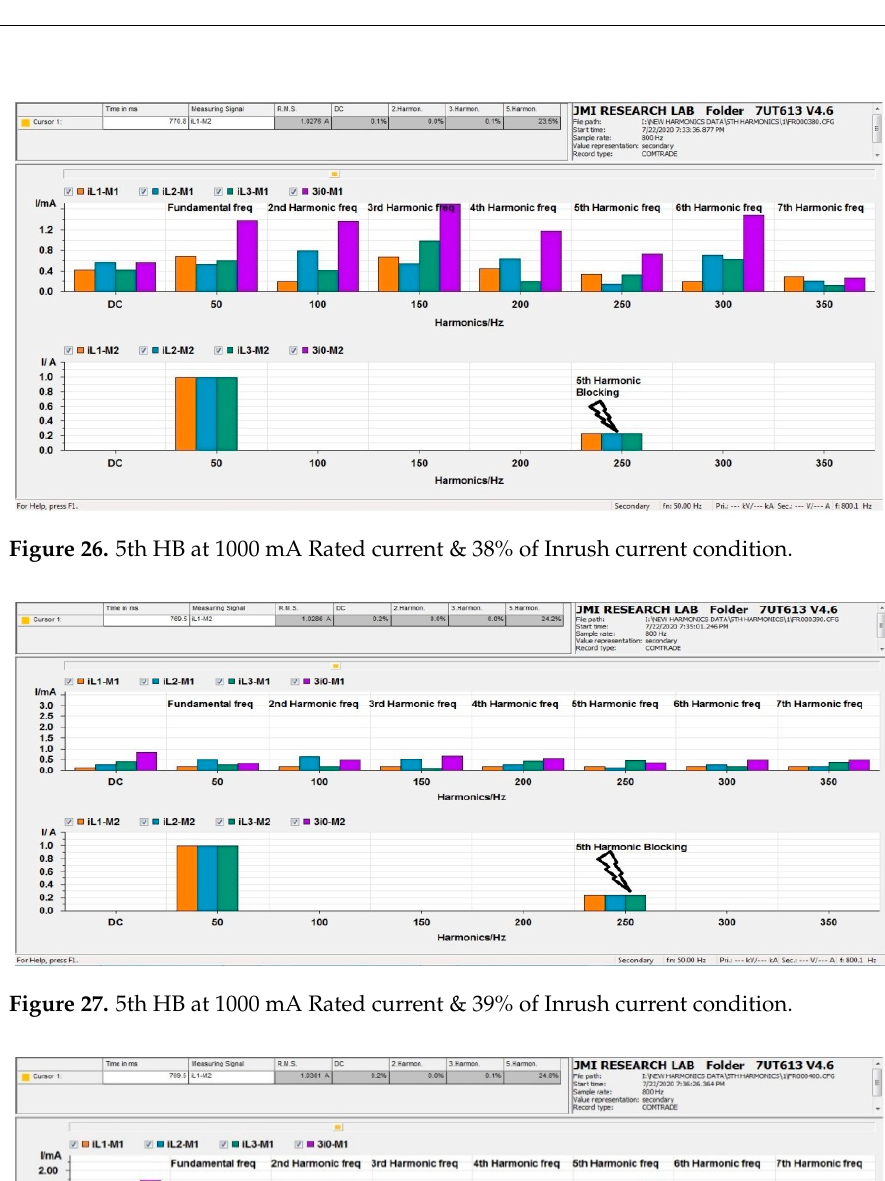
Figure 25. 5th HB at 1000 mA Rated current & 37% of Inrush current condition.